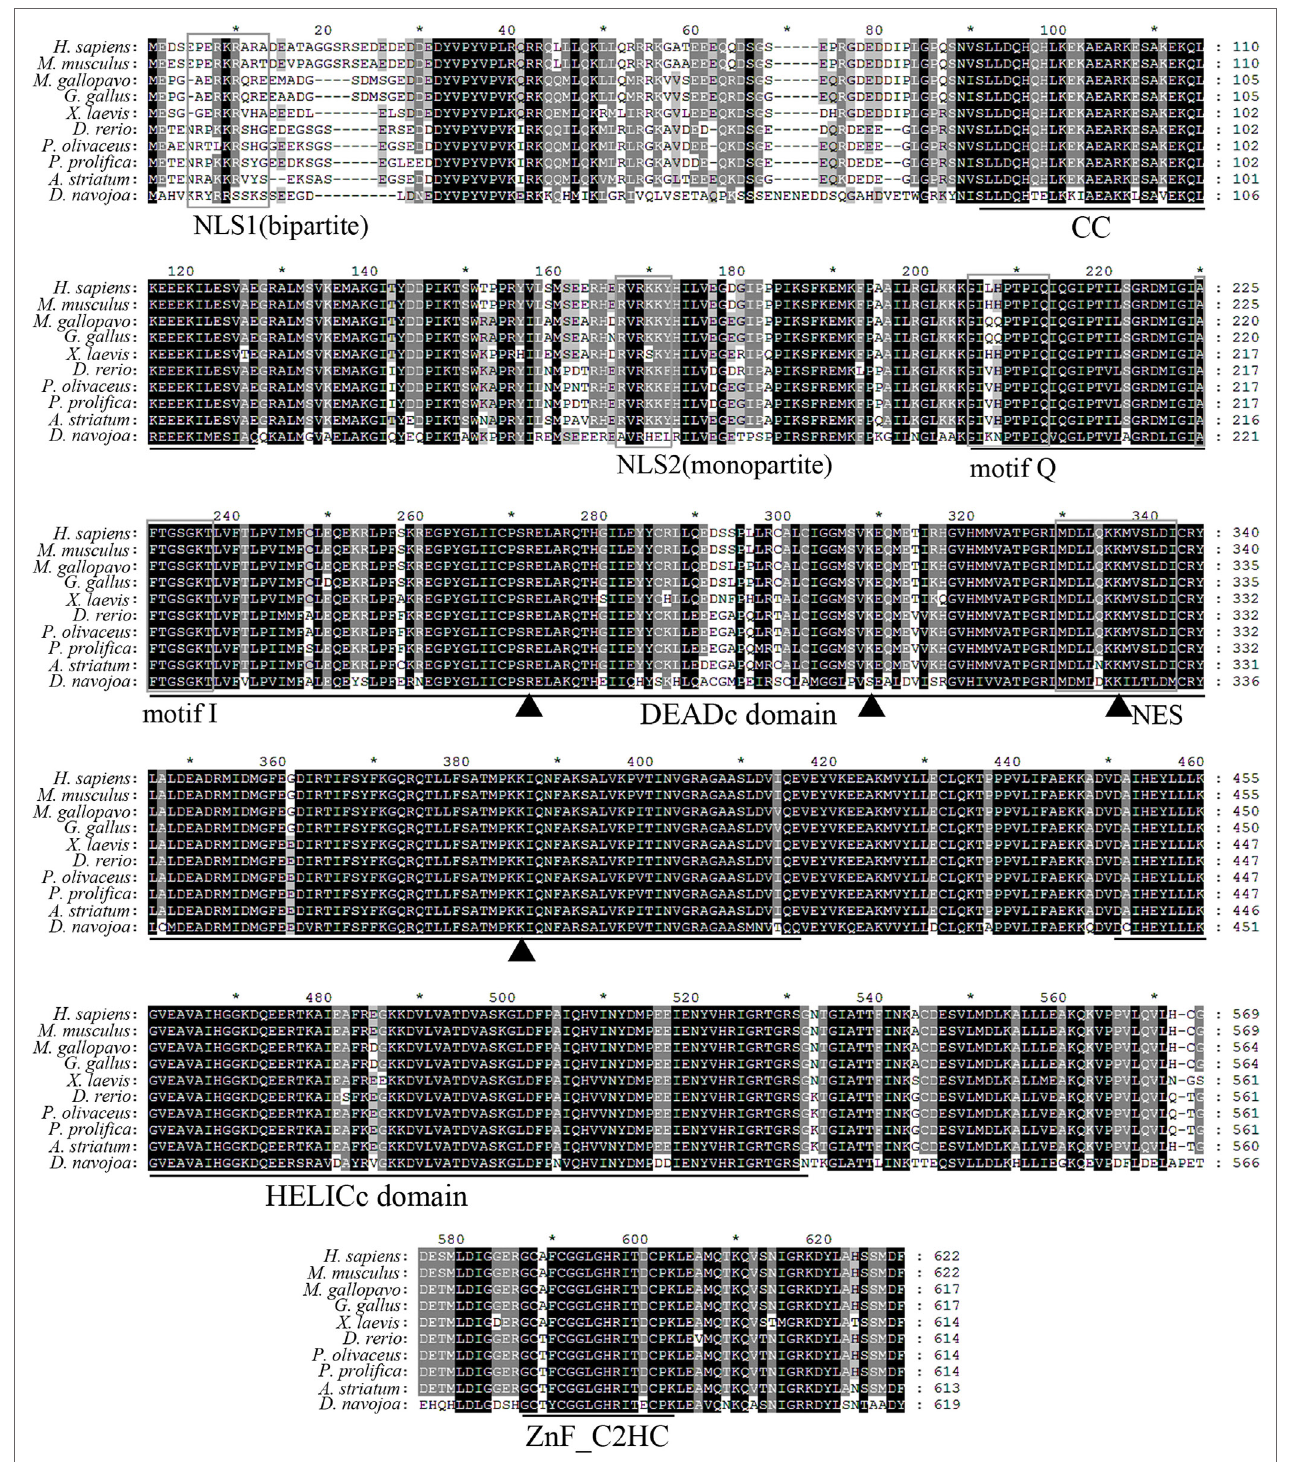
FigUre 1 | Multiple alignment of Danio rerio DDX41 with other orthologs. Residues shaded in black are completely conserved across all the species aligned, whereas residues shaded in gray are similar with respect to side chains. The dashes in the amino acid sequences indicate gaps introduced to maximize alignment. The four conserved domains coiled-coil (CC), DEADc, HELICc, and ZnF_C2HC are indicated below the alignment. The nuclear localization signal (NLS)1, NLS2, motif Q, motif I, and nuclear export signal (NES) consensus sequences are boxed. Triangles indicate the four important residues in the double-stranded DNA or cyclic dinucleotide